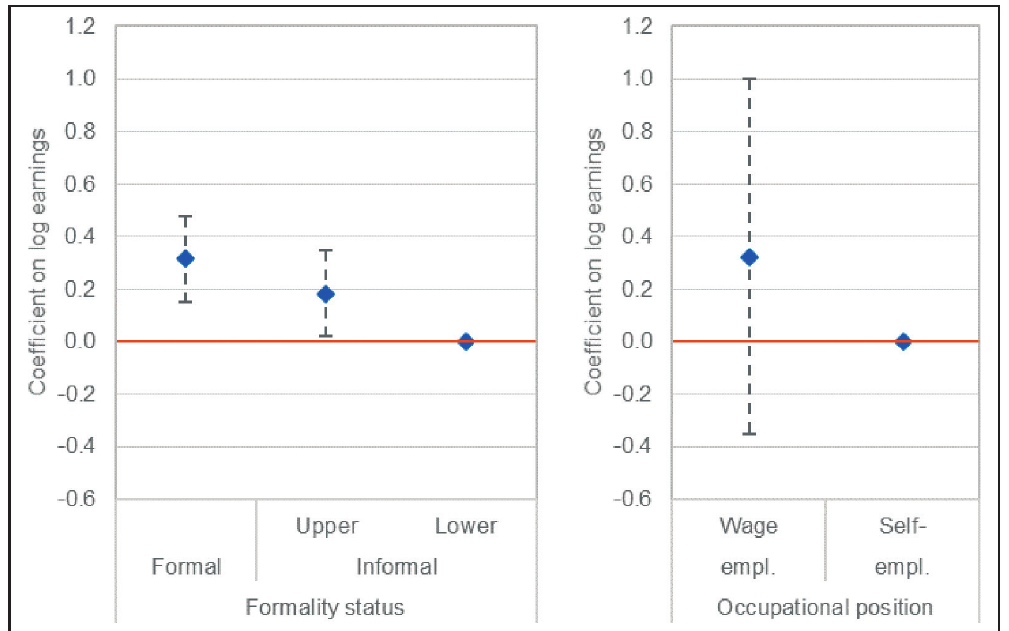
Figure C4 Coefficient estimate on log earnings, panel fixed effects